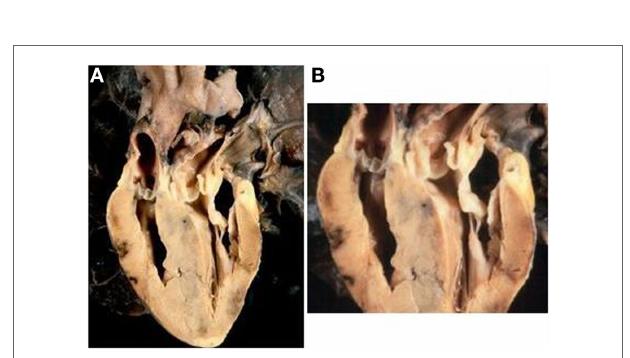
FigUre 7 | complete Tga with intact septum and subpulmonary stenosis . (a) Echocardiographic section of the heart showing the origin of the pulmonary artery from the left ventricle and of the aorta from the right ventricle. The ventricular septum is intact. (B) Close up of the same specimen: note the bulging of the hypertrophic ventricular septum and the presence of a fibrous shelf due to the friction with the anterior mitral leaflet.